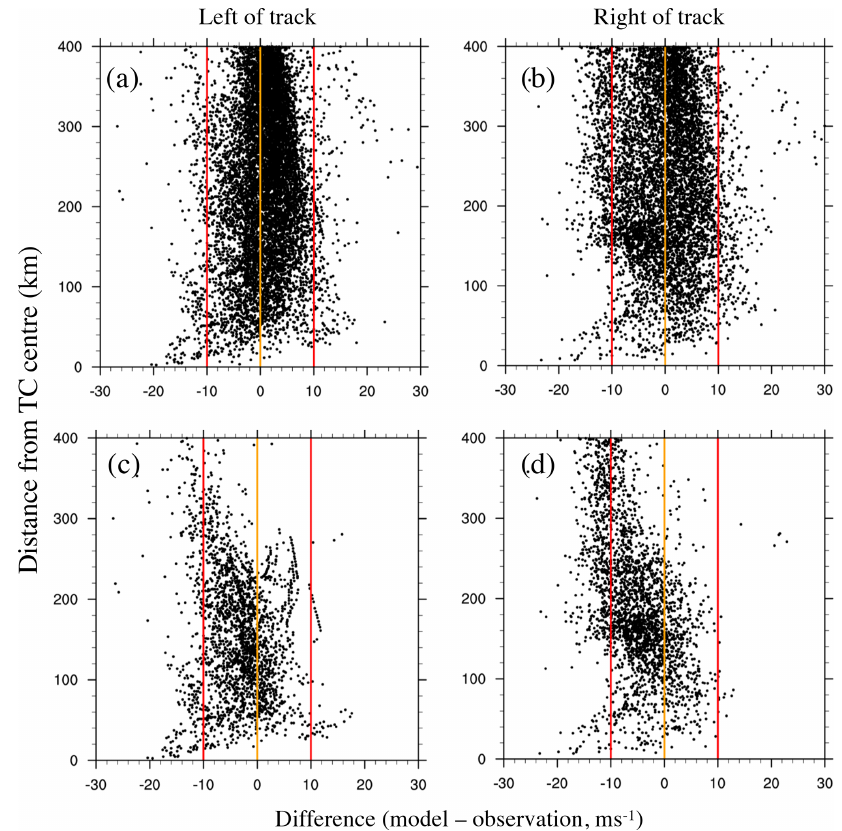
Figure 4. Difference between modelled and observed wind speeds for the eight US storms as a function of distance from the TC centre (ms − 1 ) and split into left of track (a, c) and right of track (b, d) . Panels (a) and (b) show all data points, and panels (c) and (d) show only urban data points that experienced observed wind speeds greater than 18ms − 1 . The orange lines indicate zero difference, and the red lines indicate a positive and negative difference of 10ms − 1 .